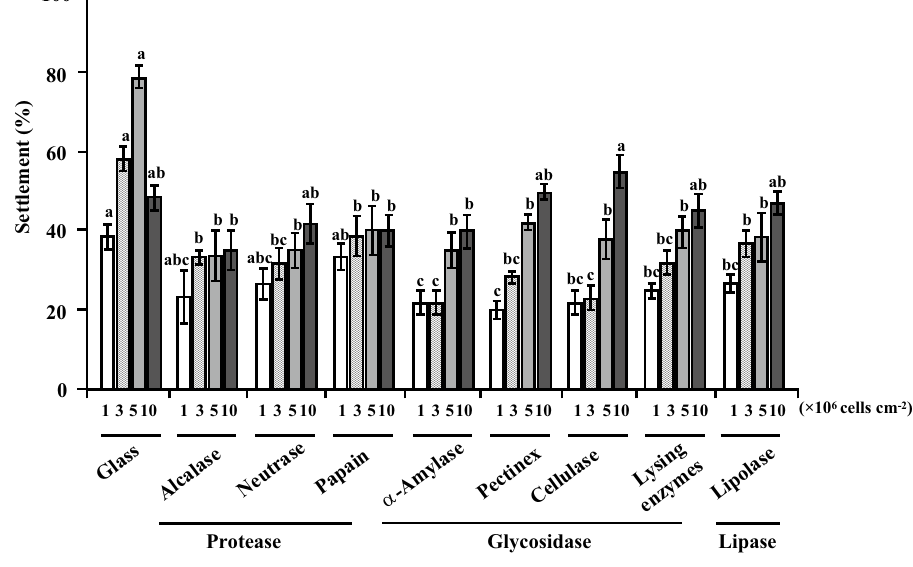
Figure 6. Percentage of mussel settlement on S. marisflavi biofilms treated with different enzymes. Small letter indicates significant variance ( P <